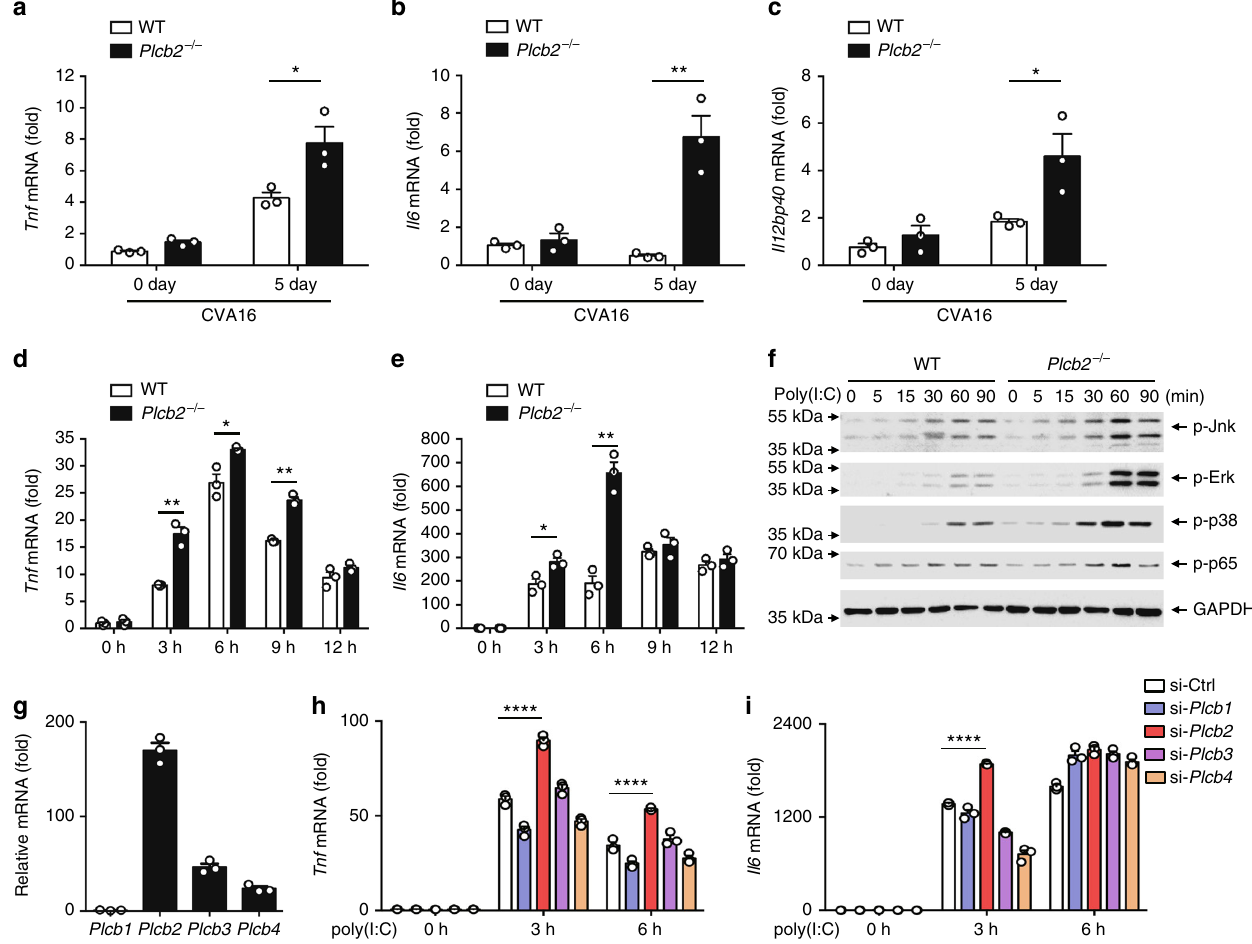
Fig. 2 PLC β 2 suppresses RNA virus-induced in fl ammation. a – c Q-PCR analysis of relative Tnf ( a ) , Il6 ( b ), and Il12p40 ( c ) mRNA levels in skeletal muscle tissue from 14-day-old wild-type or Plcb2 − / − mice infected with 50 μ l of CVA16 virus (1.5 × 10 4 PFU/mouse) for 0 or 5 days. d , e Q-PCR analysis of relative Tnf ( d ) and Il6 ( e ) mRNA in wild-type or Plcb2 − / − macrophages treated with poly(I:C) for the indicated times. f IB of lysates from wild-type or Plcb2 − / − macrophages treated with poly(I:C) for the indicated times using anti-phospho-antibodies. g Q-PCR analysis of relative Plcb1-4 mRNA levels in mice peritoneal macrophages. h Q-PCR analysis of relative Tnf ( h ) and Il6 ( i ) mRNA in Plcb1-4 silence macrophages stimulated with poly(I:C) for the indicated times. * p < 0.05; ** p < 0.01 and **** p < 0.0001 by unpaired t -test ( a – e , h and i ). Data are representative of three experiments with at least three independent biological replicates (mean and s.e.m. of n = 3 cultures in d – i or n = 3 mice per group in a – c